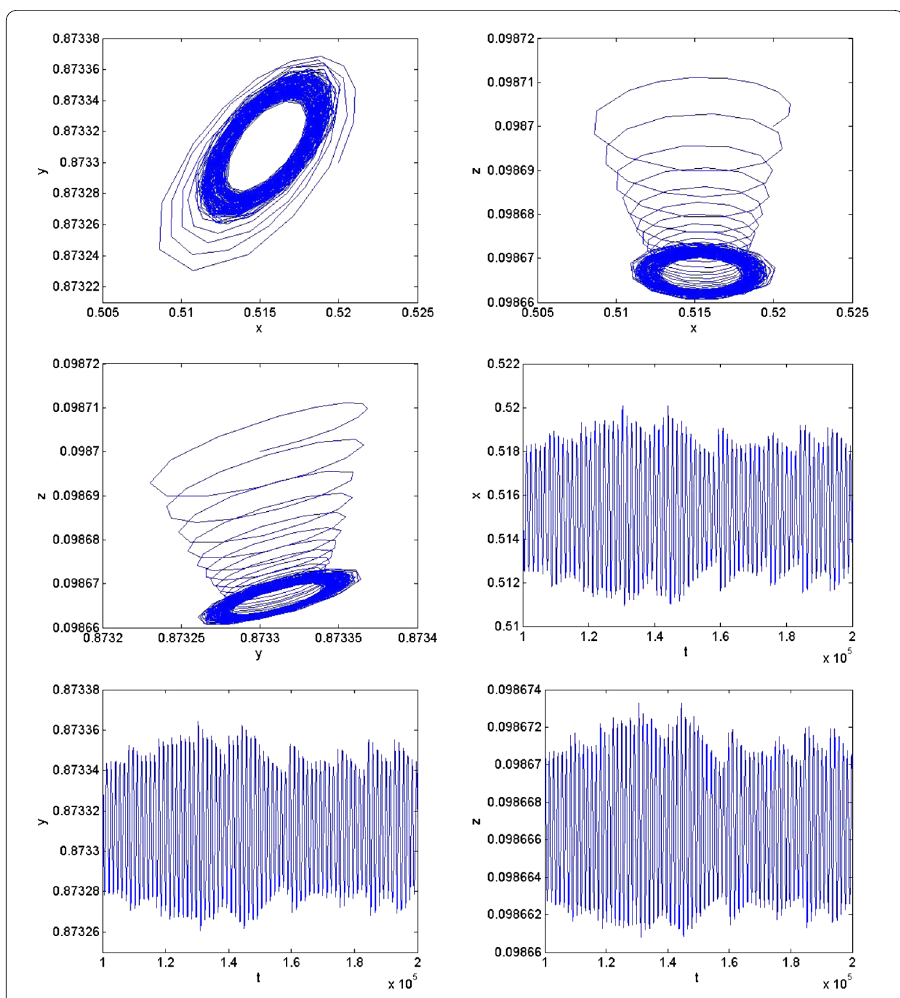
Figure 11 A computer simulation of the system of Eqs. (4)–(6) with c 1 = 0.85 day –1 , c 2 = 0.95 day –1 , c 3 = 0.239 day –1 , c 4 = 0.84 day –1 , c 5 = 0.5 day –1 , k 1 = 67.5, k 2 = 0.02, k 3 = 0.9, h 1 = 0.024, h 2 = 0.063, e 1 = 0.0001 day –1 , e 2 = 0.95 day –1 , e 3 = 0.56 day –1 , γ 1 = 0.02 day –1 , γ 2 = 0.085 day –1 , (cid:8) = 0.004 and δ =